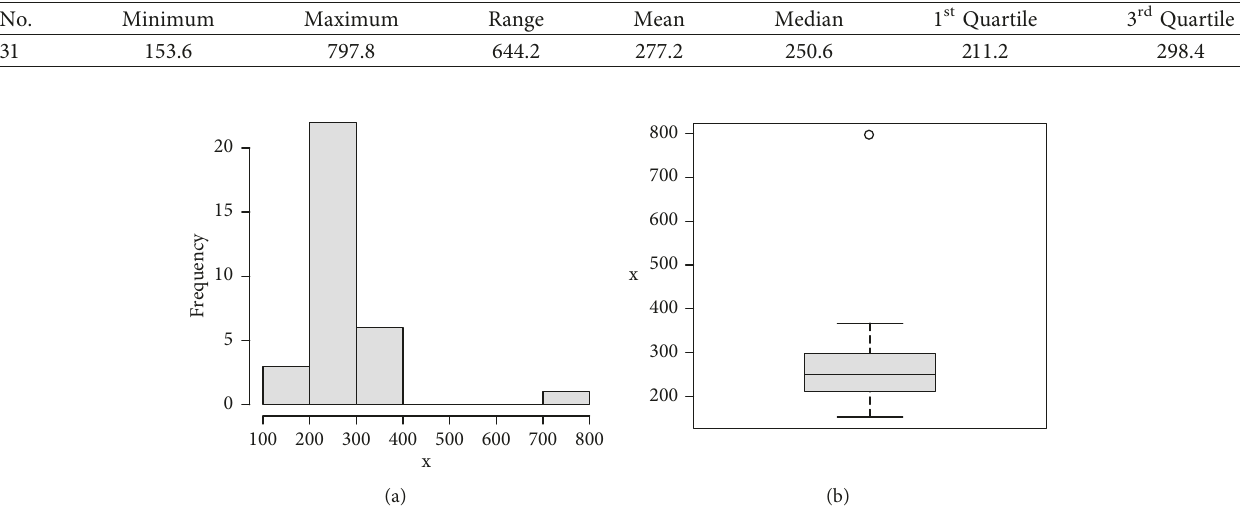
Figure 7: (a) Histogram and (b) box plot of collision data. Table 9: Parameter estimates and standard errors for collision